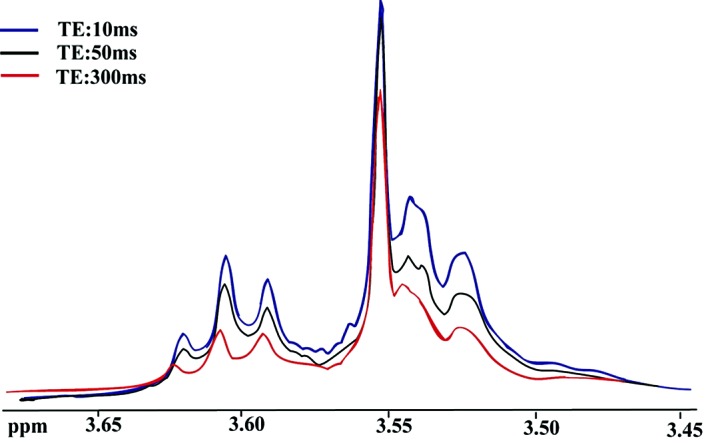
In vitro experimental 1D CMPG 1H HRMAS spectra of Gly and Myo. The Gly singlet is at 3.55 ppm, the Myo M2 doublet is at 3.53 ppm, and the Myo N2 triplet is at 3.61 ppm.